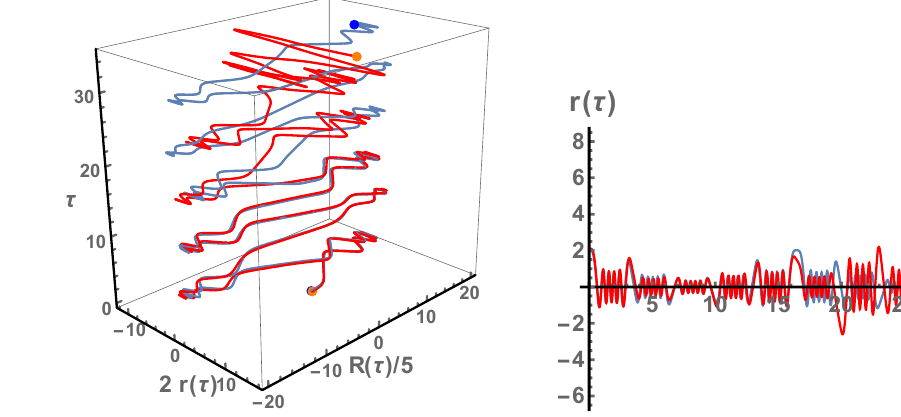
Figure 1 . The evolution of string motion along the holographic direction and its ra- dius. The two strings have close initial con- ditions while the (cid:12)nal endpoints begin to di(cid:11)er signi(cid:12)cantly. We simulate the motion until the initial moments of the chaos ap- pearance. The axes have been rescaled for better optical results.